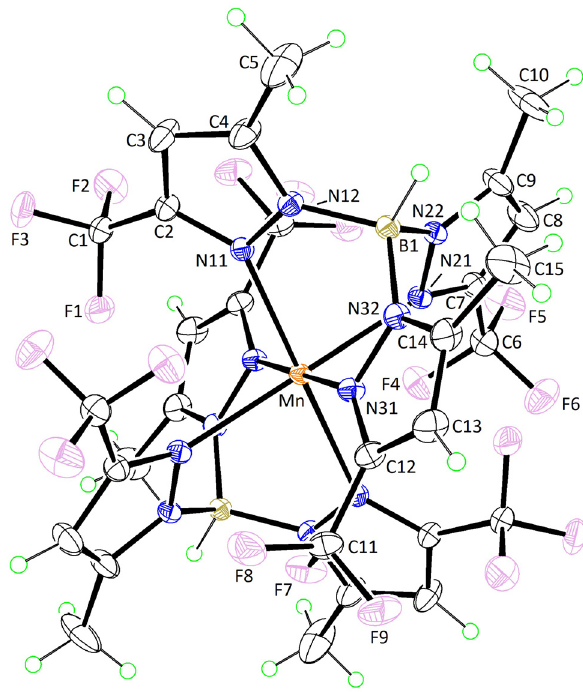
Table  : Data collection and